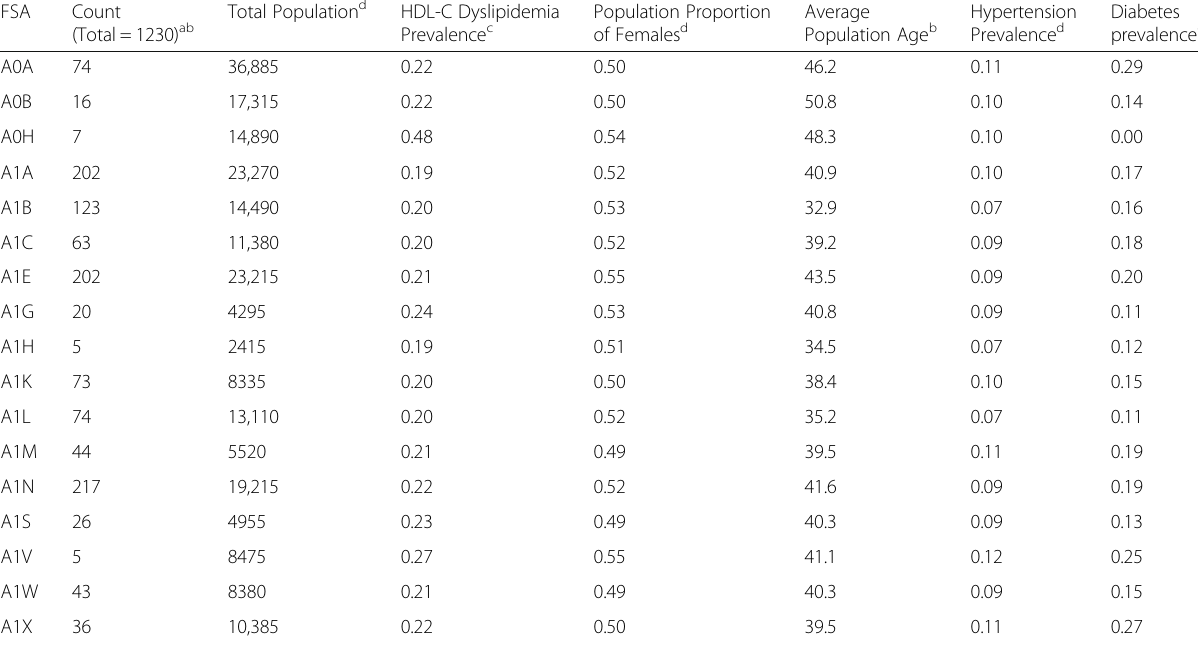
Table 3 Population variations in community risk factors, obtained from LIS and DEPICT FSA Count (Total = 1230)